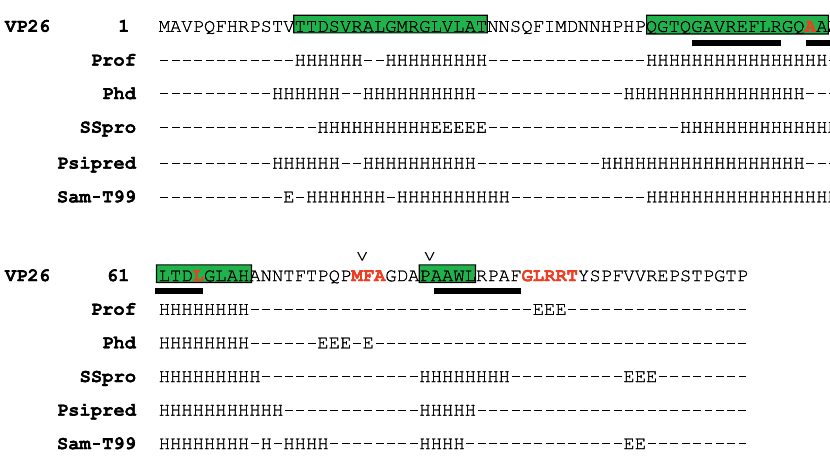
Five secondary-structure prediction algorithms were used to compute the secondary structure (highlighted in green) of VP26. Mutations identified by Desai et al . [32] are highlighted in red. Helices based on model 8824 are represented by a black bar beneath the primary sequence. The locations on the VP26 sequence corresponding to the VP1–3 insertions (Figure 6) are labeled with ‘‘ v ’’ above the primary sequence. DOI: 10.1371/journal.pcbi.0020146.g003